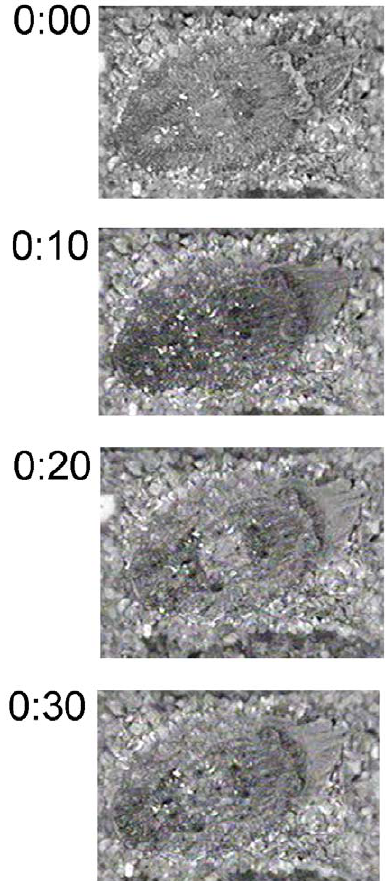
Figure 2. A putative sleep-like state with chromatophore activity (CA) in the cuttlefish Sepiaofficinalis . Video still frames from a representative adult/senescent cuttlefish exhibiting changing chromatophore activity during quiescence. These 4 frames show 10 second, sequential frames beginning with quiescence (0:00) and 30 seconds of the sleep-like state + CA. The camera was positioned vertically over the animal, resting on the gravel bed; the front of the animal is pointed towards the upper right corner. Changes in chromatophore components include a darkening of the body and a disappearance of a white eye-bar (0:00–0:10), a lightening of the body, the appearance of a white square (0:10–0:20) and a subsequent disappearance of the white square (0:20–0:30). Body color components as defined as described by Hanlon et al [20]. See supporting information (Videos S1,S2) for representative videos of this sleep-like state + CA.